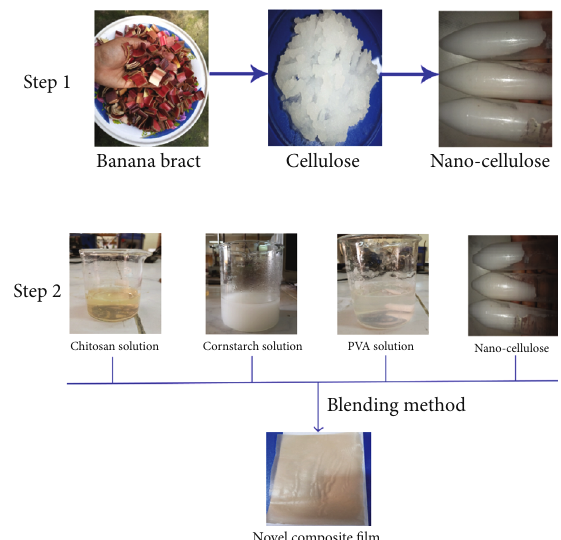
Figure 1: Physical view of novel composite fi lm preparation.